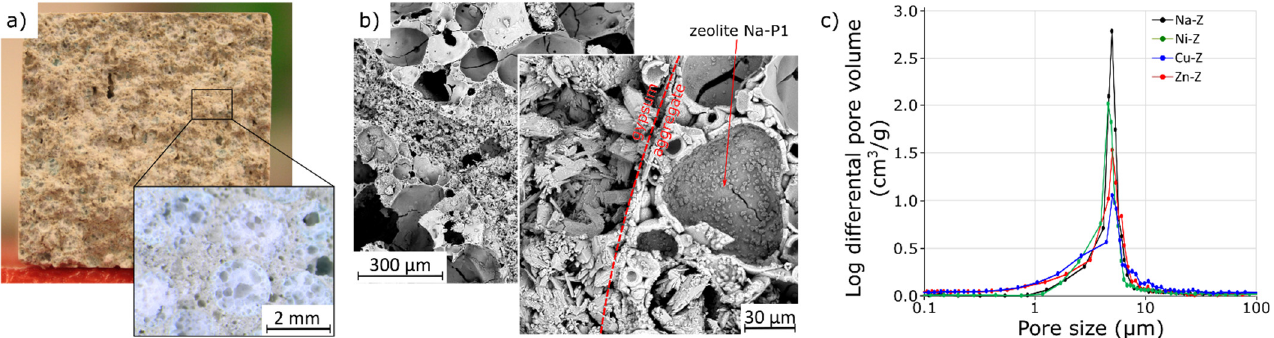
Figure 5. The analyzed fresh split surface of gypsum paste: photographs of plaster bar fractures with zeolite granulate ( a ), SEM microphotographs of relevant samples ( b ), and differential distribution curve of gypsum plasters measured by MIP ( c ).